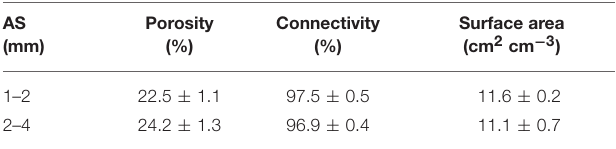
and 2–4mm packed at a bulk-density of 1.3g cm − 3 . AS (mm)